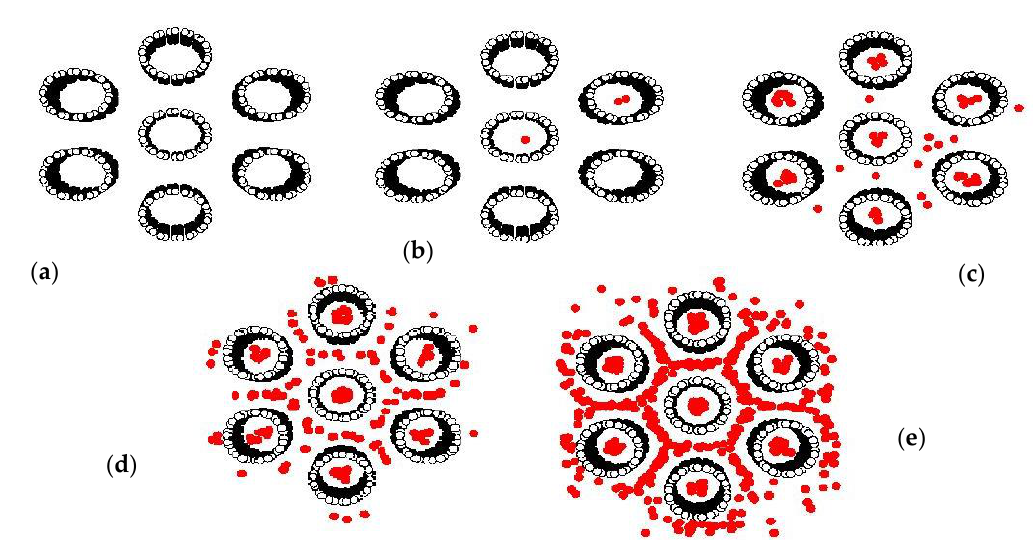
Figure 15. Snapshots of CH 4 adsorption at various pressures: p = 0.3 ( a ), 1 ( b ), 900 ( c ), 8000 ( d ) and 90,000 Pa ( e ) in 10.8 Å tubes at 273 K and TWD of 7 Å .